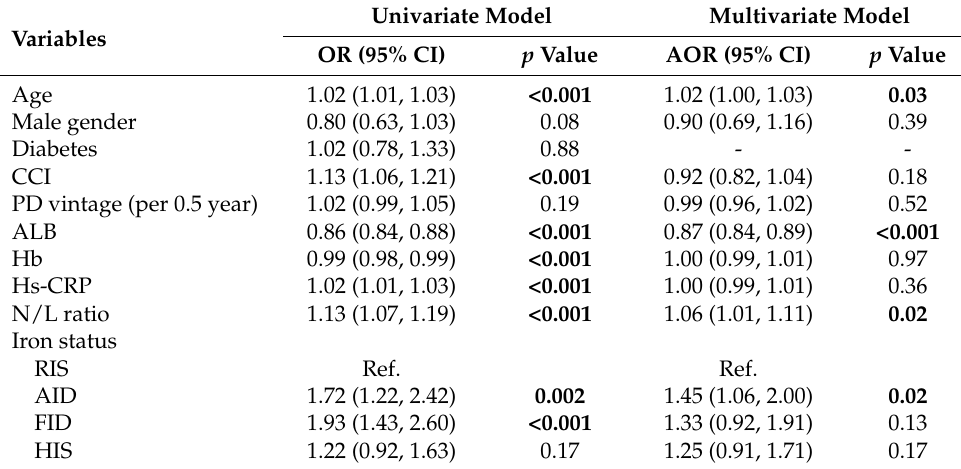
Table 2. Univariate and multivariate GEE analysis of longitudinal iron status and the episodes of peritonitis in PD patients.